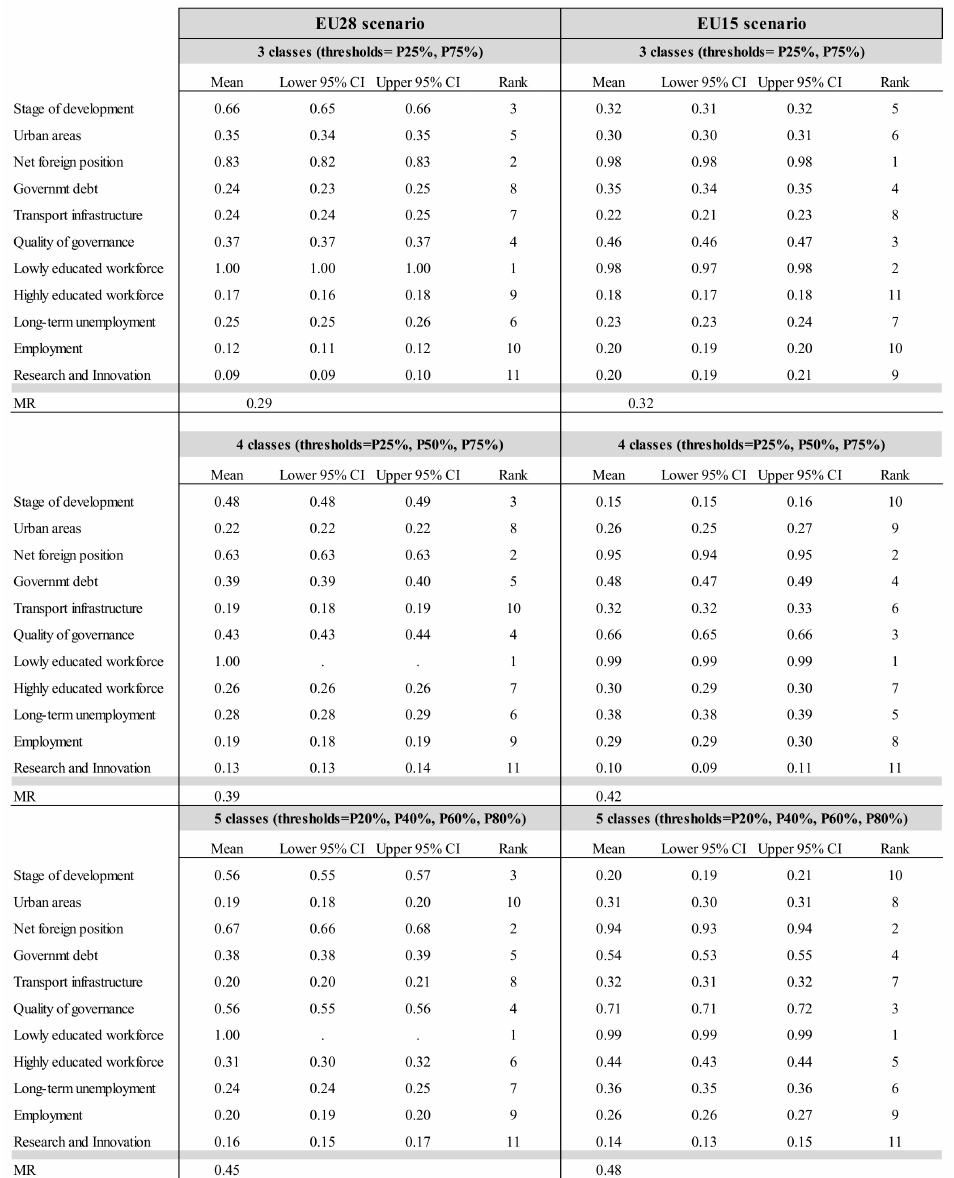
Table A.2: CART robustness analysis for the EU28 (left column) and the EU15